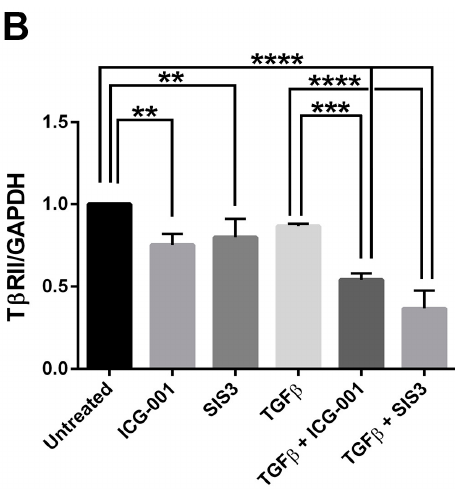
Figure 4. Reverse transcriptase PCR (RT–PCR) for T β RII, and GAPDH . cDNA transcribed from RNA isolated from lens explants incubated with TGF- β in the presence or absence of SIS3 or ICG-001 were amplified using PCR, then visualized on a 1.5% agarose gel by electrophoresis, using GAPDH as a standard control. ( A ) Representative image of the RT–PCR gel showing mRNA levels of T β RII and GAPDH. The PCR sample without cDNA served as a negative control. ( B ) Graph showing statistical analysis (ANOVA–Tukey’s multiple comparisons test) of band densities for T β RII normalized to respective GAPDH. Error bars indicate standard deviation. p < 0.01 for untreated vs. ICG-001- and SIS3 –treated LECS; p < 0.0001 for untreated vs. TGF- β + SIS3 and TGF- β + ICG-001 co-treated LECs;